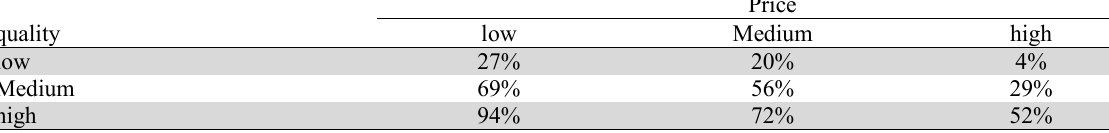
Probability of purchasing the product based on price and quality